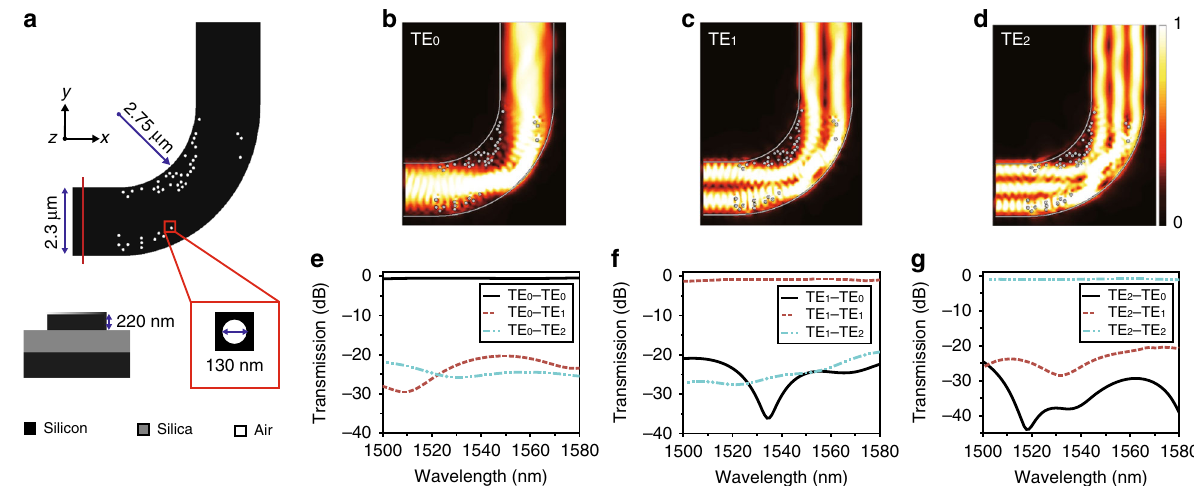
Fig. 1 Design and simulation results of the digital meta-structure (DMS)-based bending. a Schematic diagram of the designed three-mode bending with DMS. b ‒ d The simulated optical fi eld distributions for the micro-bend with three modes (TE 0 ‒ TE 2 ). e ‒ g The simulated transmission spectra for the micro- bend with three modes (TE 0 ‒ TE 2 )